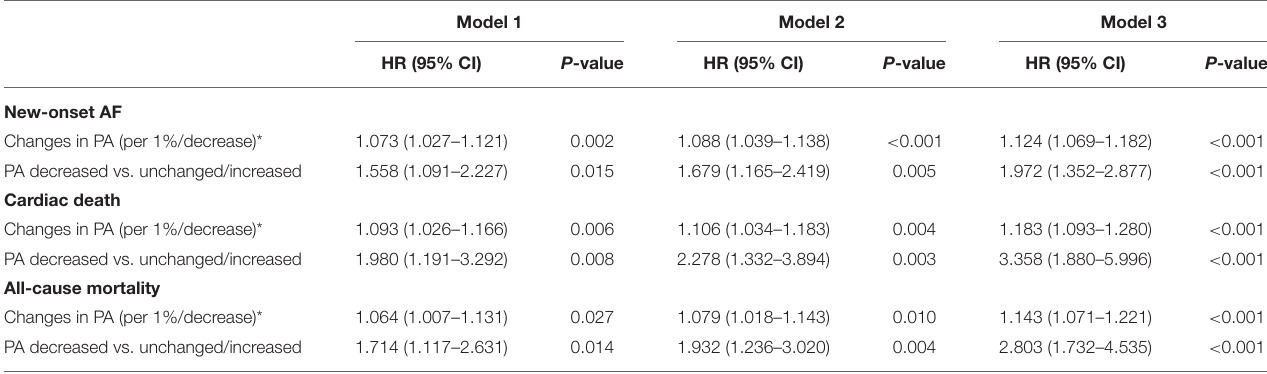
TABLE 2 | Changes in PA associated with clinical outcomes.